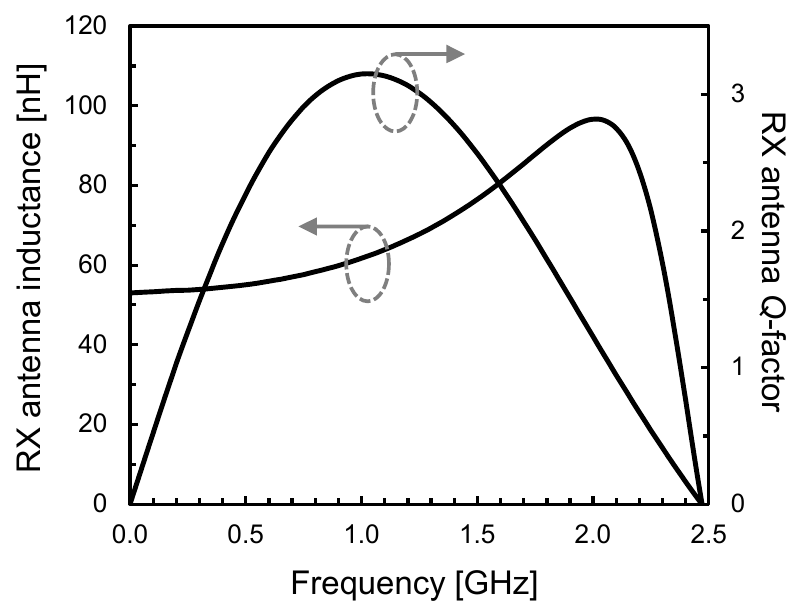
Figure 16. Inductance and Q -factor of the RX antenna for step C.